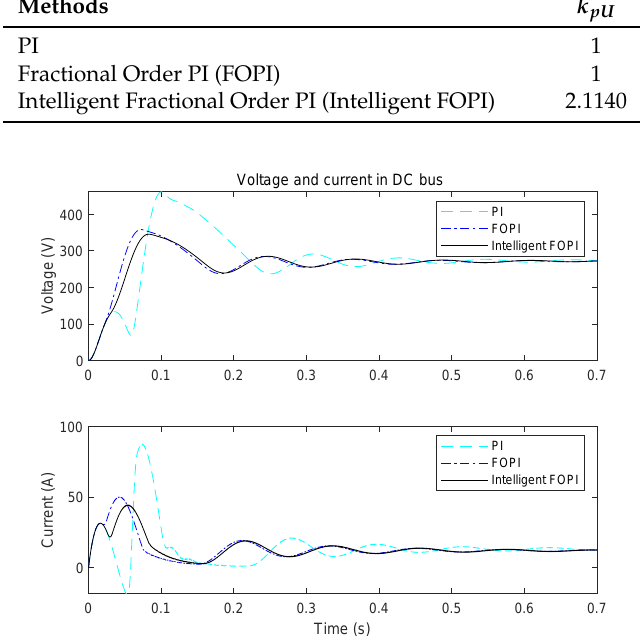
Figure 20. DC voltage and current comparison among three control methods.